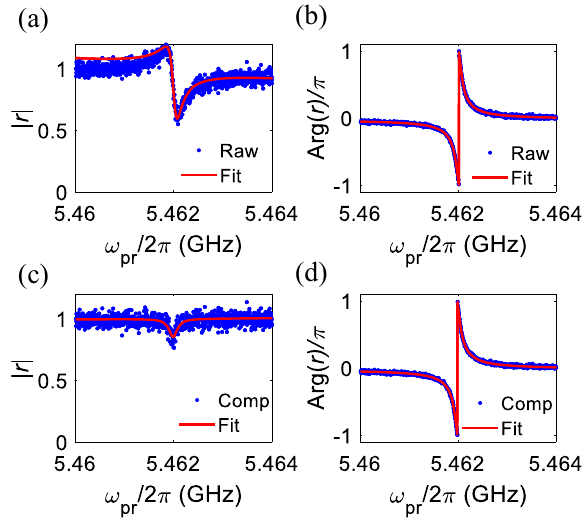
Fig. 8 Impedance mismatch. Panels a , b are the magnitude and phase response of the re fl ection coef fi cient before compensating the impedance mismatch. Panels c , d are the magnitude and phase response of the re fl ection coef fi cient after compensating the impedance